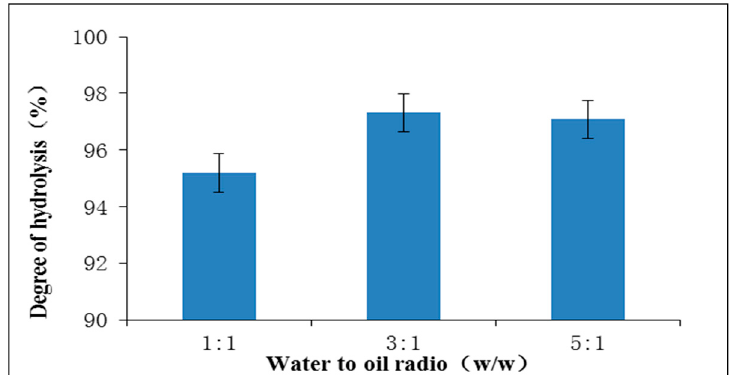
Figure 10. The effect of water dosage on the hydrolysis of Schizochytrium sp. oil. (95 °C, 1% Sodiumdodecyl-sulfate based on oil weight, 1.4 mol/L sulphuric acid, 750 rpm).